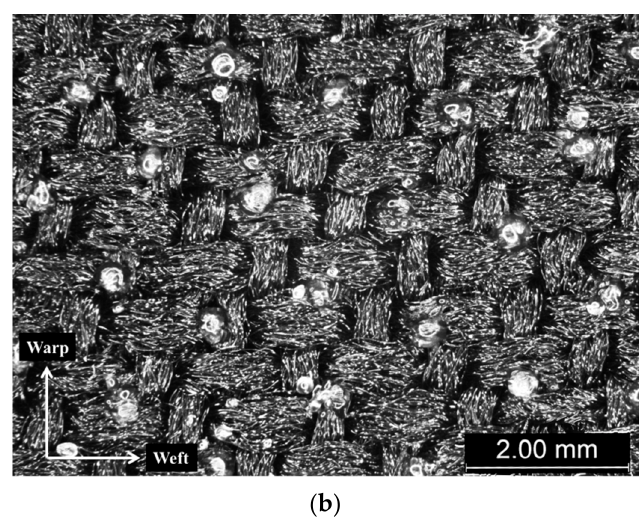
Figure 1. Woven Interlining ( a ) and Microscope Views of Woven Interlining ( b ).